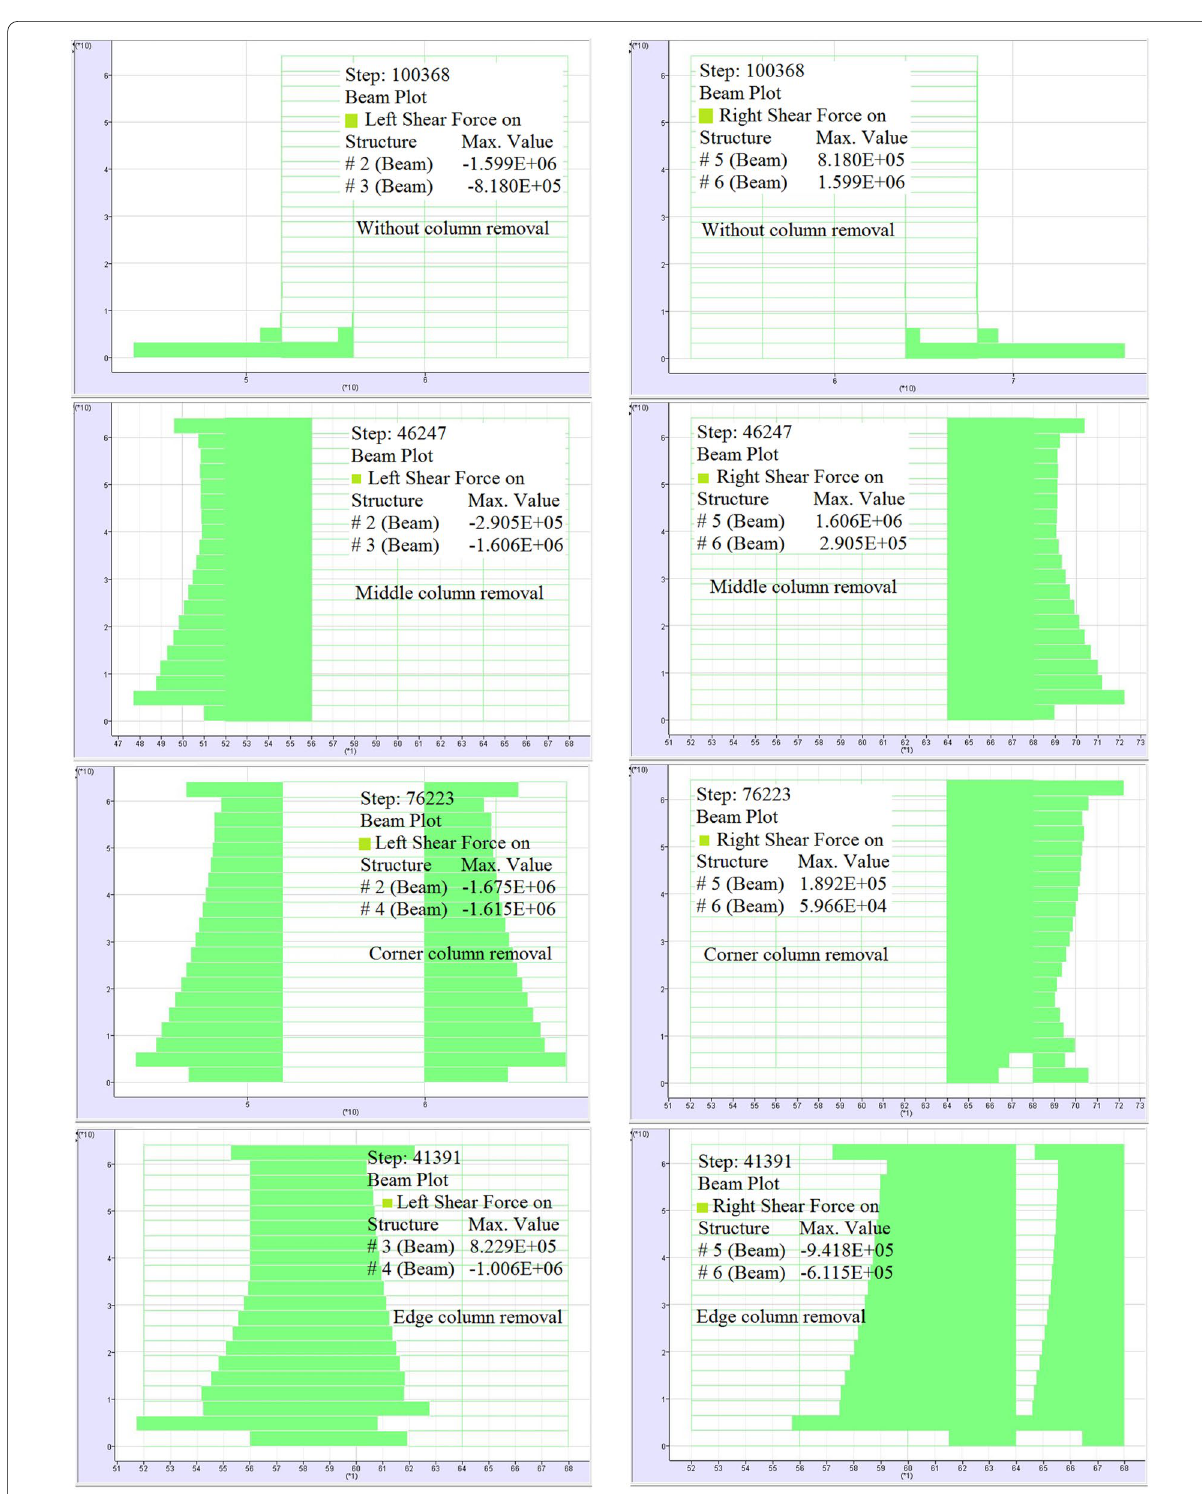
Fig. 7 Total base shear of the RC frames with and without column removal in various